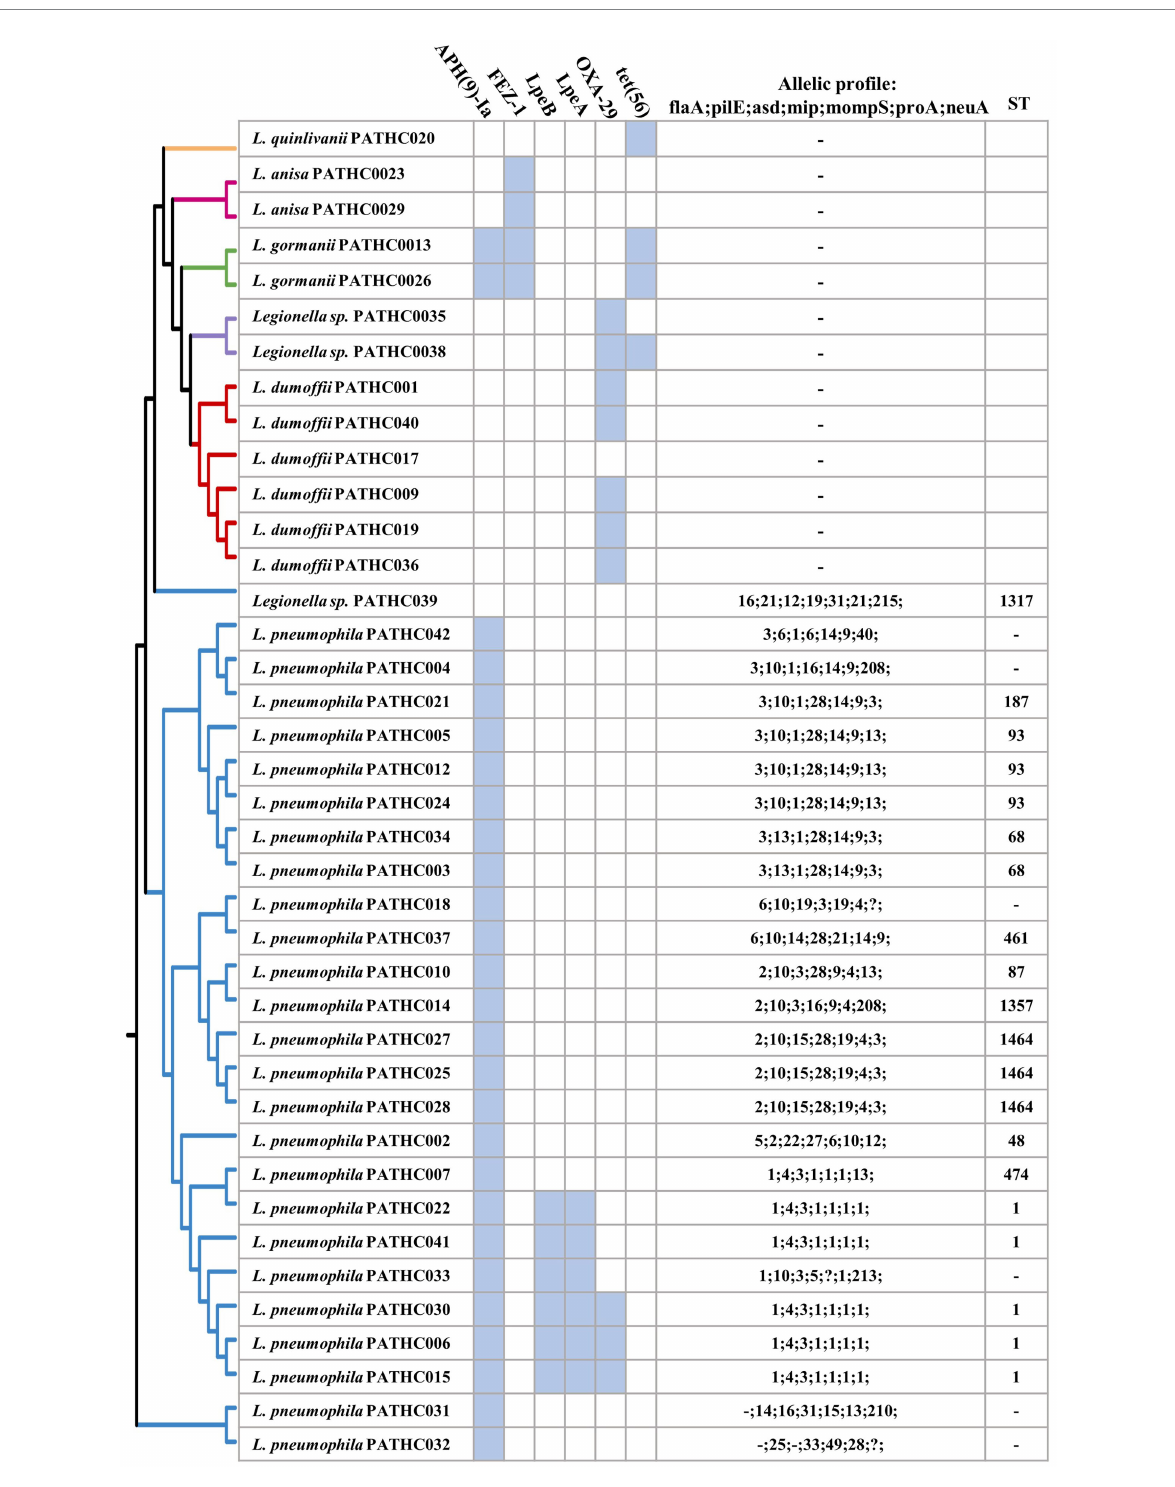
FIGURE 3 Antimicrobial resistance genes and sequence-based typing of Legionella isolates in this study grouped by pangenome tree constructed using the BPGA pipeline. Antimicrobial genes were predicted in silico searching the CARD database. Sequence-based typing was conducted in silico utilizing legsta tool which contains sequence base type profiles from the Public Health England database.